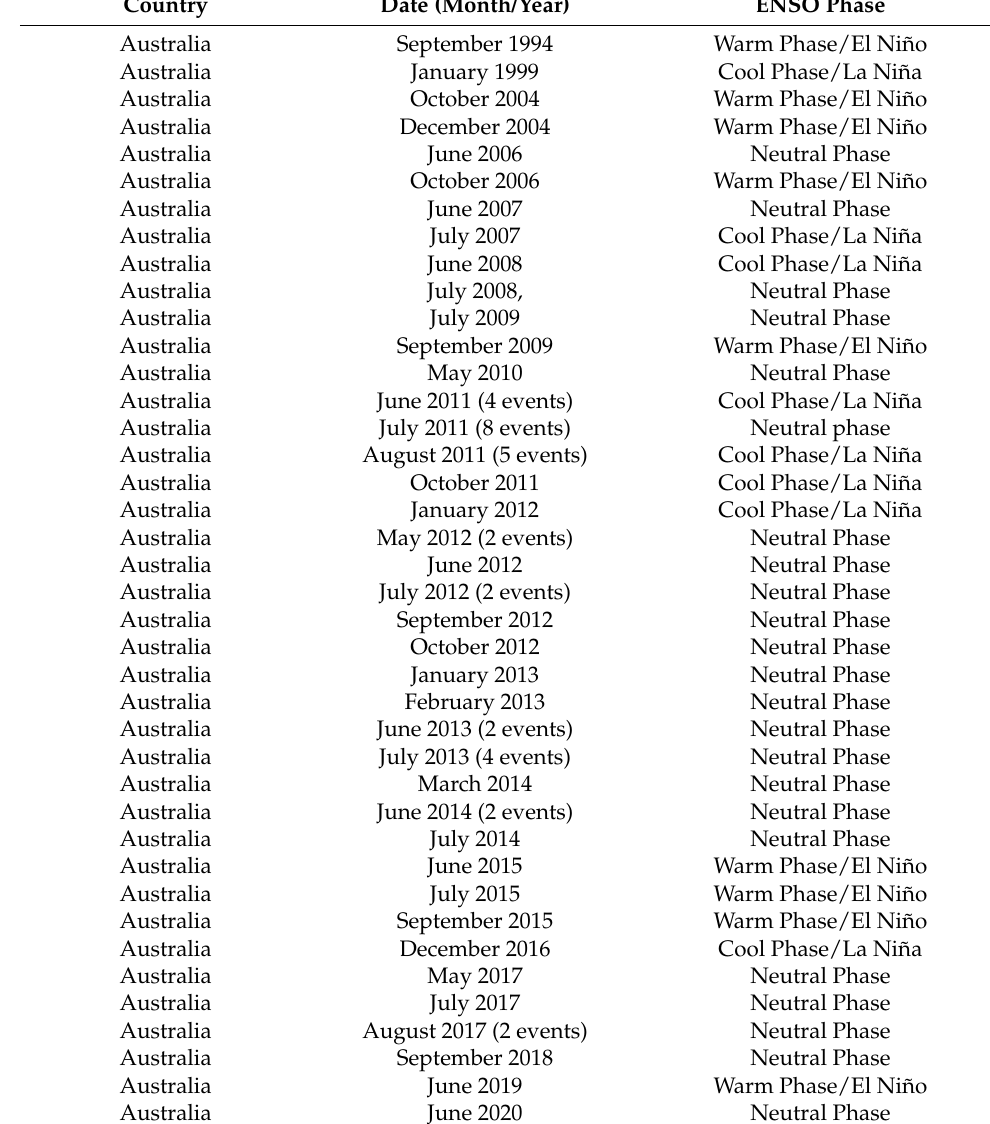
Table 3. Recurring spillover events of the Hendra virus after its first emergence in Australia in relation to El Niño Southern Oscillation (ENSO)-driven climate anomalies (data on ENSO were retrieved from NOAA). Data on outbreaks were retrieved from the Queensland Government database (https://www.business.qld.gov.au/industries/service-industries-professionals/service- industries/veterinary-surgeons/guidelines-hendra/incident-summary, accessed on 17 May